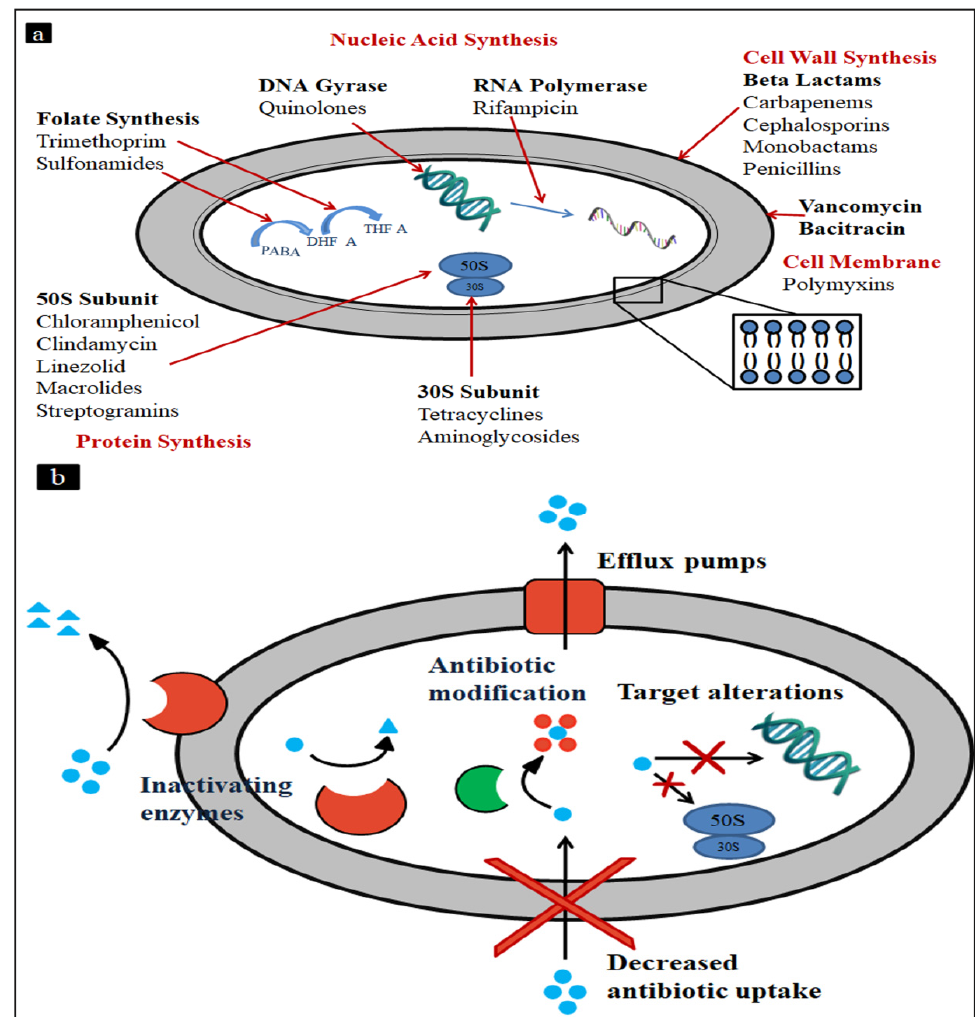
Figure 1. ( a ) Antibiotic targets and ( b ) bacterial resistance mechanism.